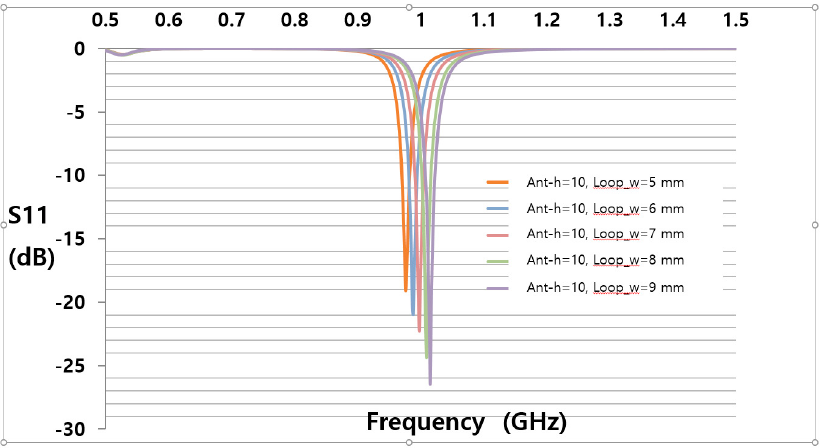
Figure 5. Simulation results of the parameter sweeps .